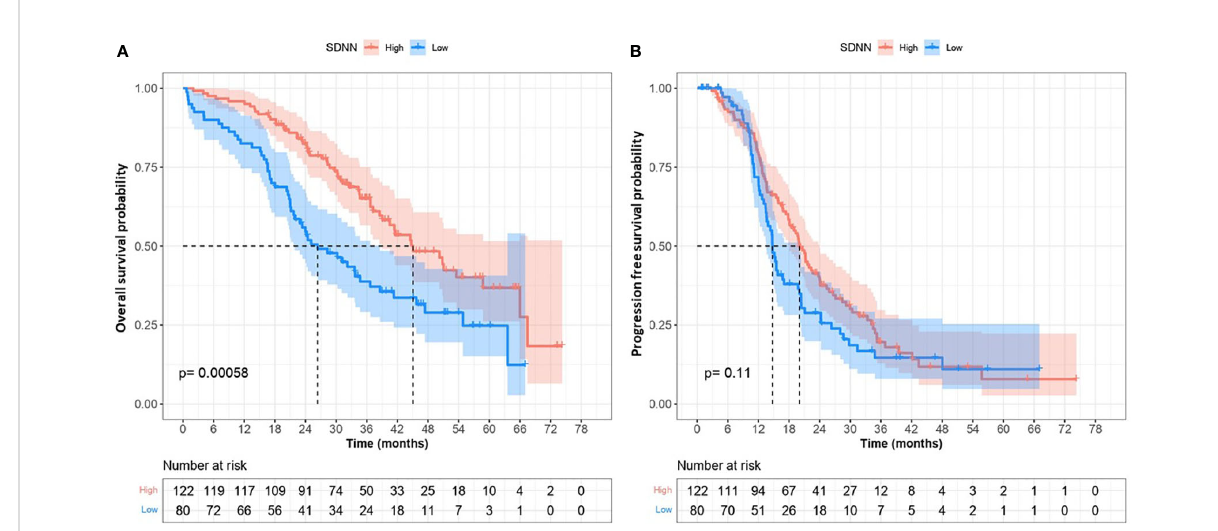
with median PFS of 14.7 and 20 months for low SDNN and high SDNN, respectively; HR= 1.31, 95%CI:0.95 - 1.82], p=0.104) (Figure 2B). In the multivariate analysis, we did not fi nd any association between HRV and PFS; only R1 resection and CA 125 level above 35UI/ml at the end of the fi rst-line treatment were still signi fi cantly associated with PFS. (Table 4). The results using RMSSD were similar to those using SDNN in terms of PFS.